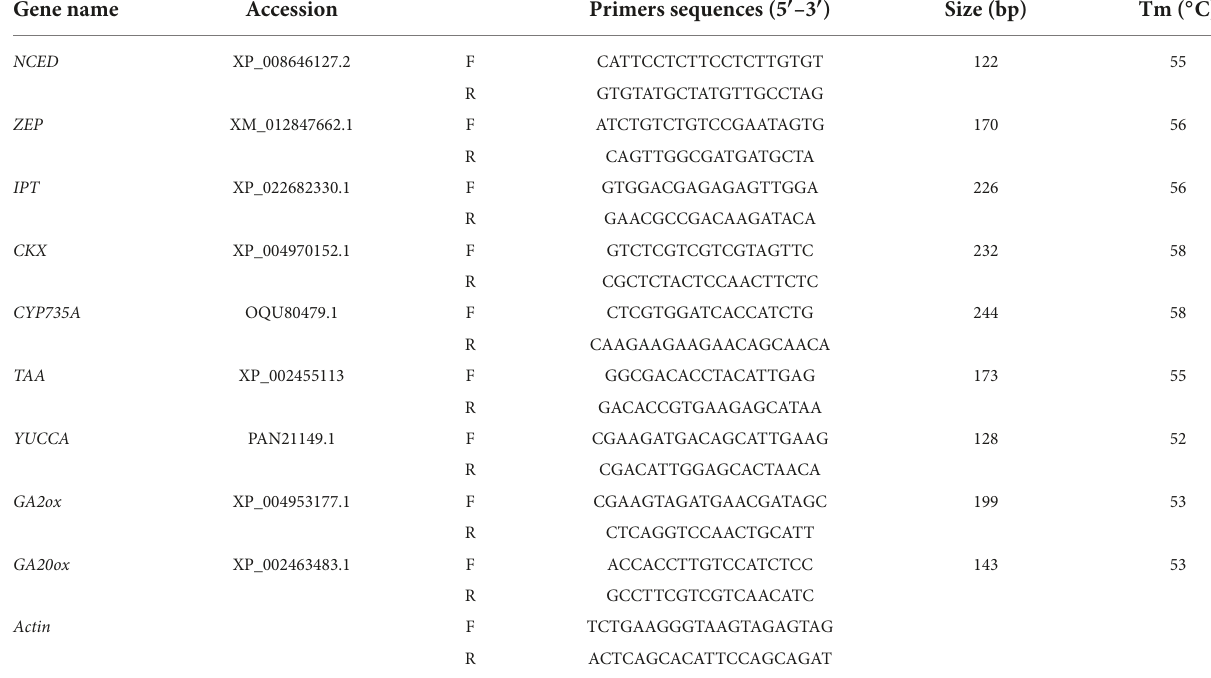
TABLE 1 Primers used for real-time quantitative PCR in this